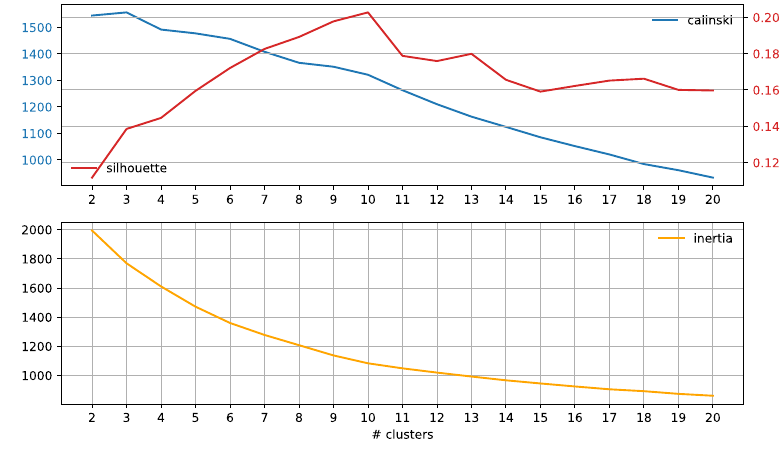
Figure A16. Subreddit fibromyalgia.